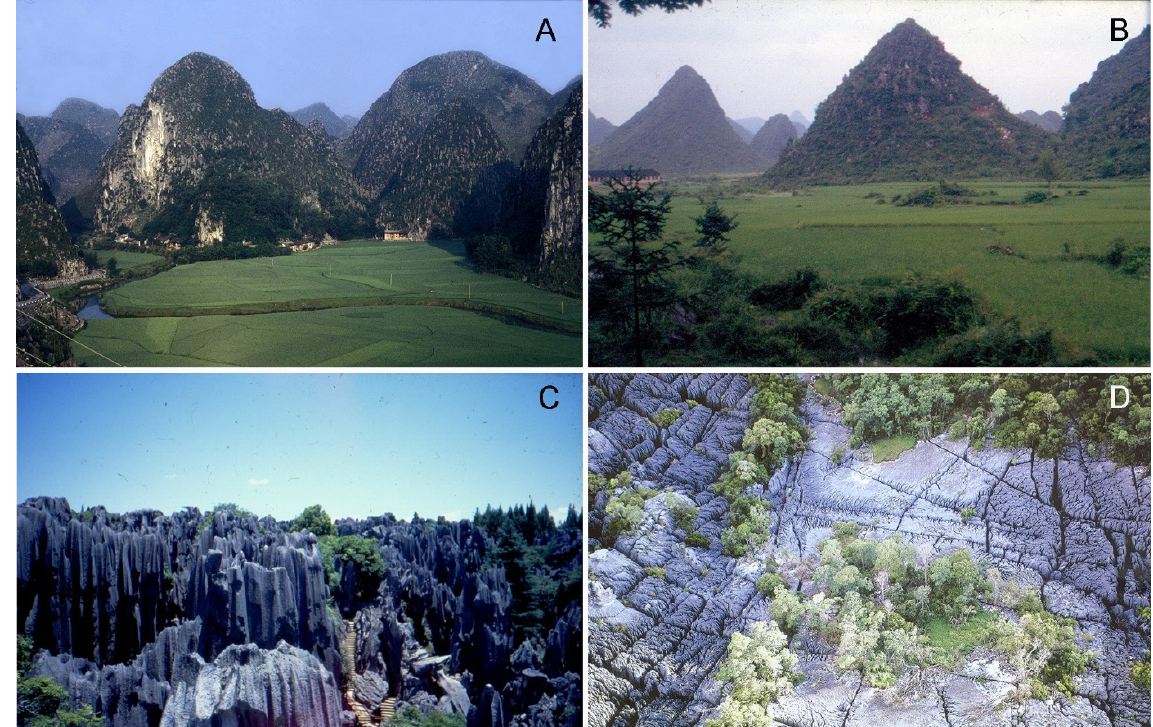
Figure 4. Zonal (tropical) karsts: ( A ) fengcong (China), ( B ) fenglin (China), ( C ) stone forest karst (Lunan, China) (photographs A – C taken by Márton Veress), ( D ) tsingy (Bemaraha tsingy, Madagascar) [36].